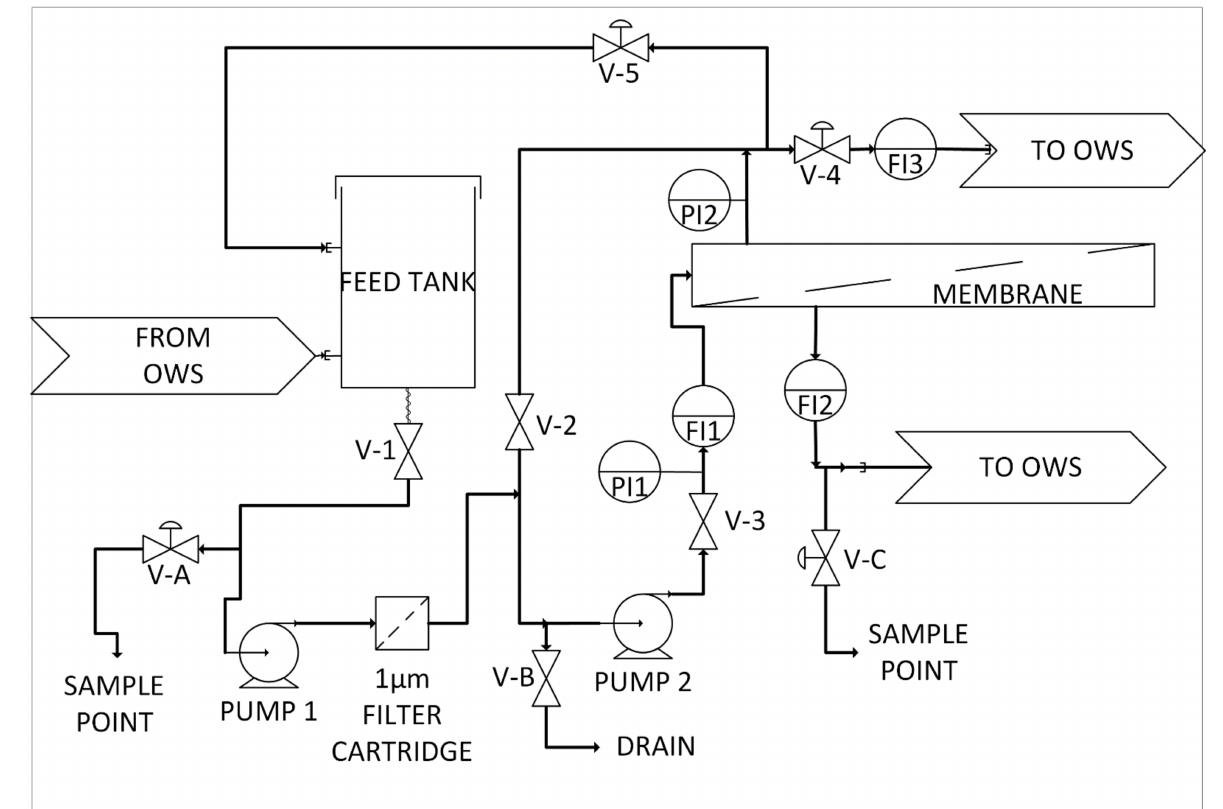
Figure 3. A schematic drawing of the pilot membrane rig used for the Bedfordshire site trials.